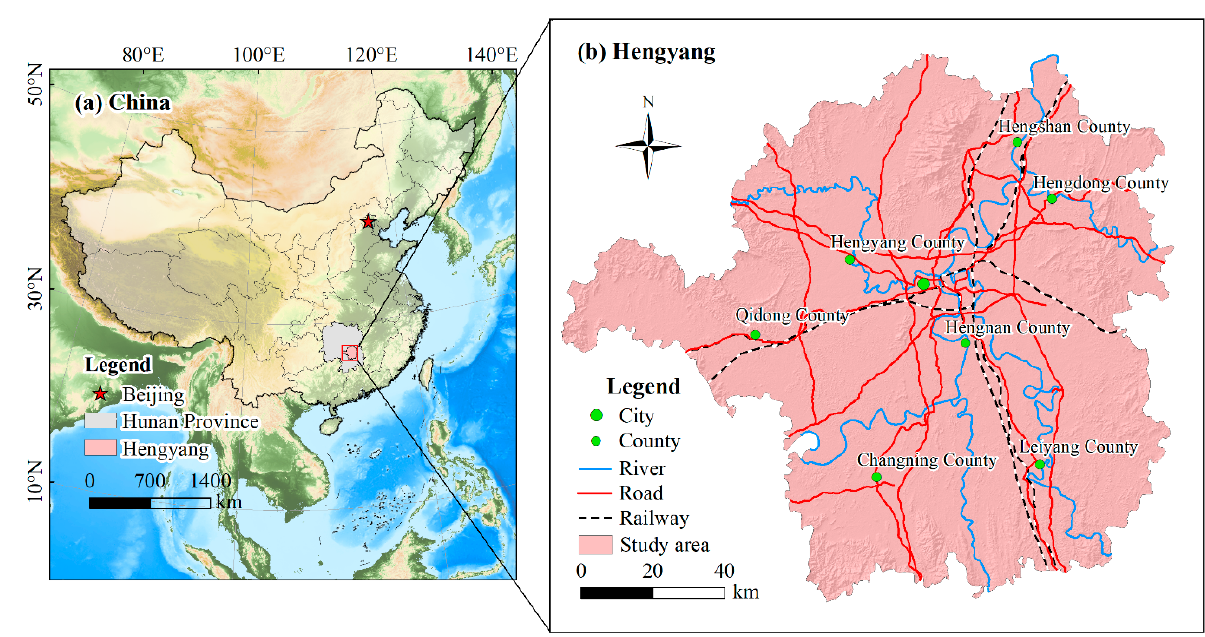
Figure 1. The geographical location of the study area.